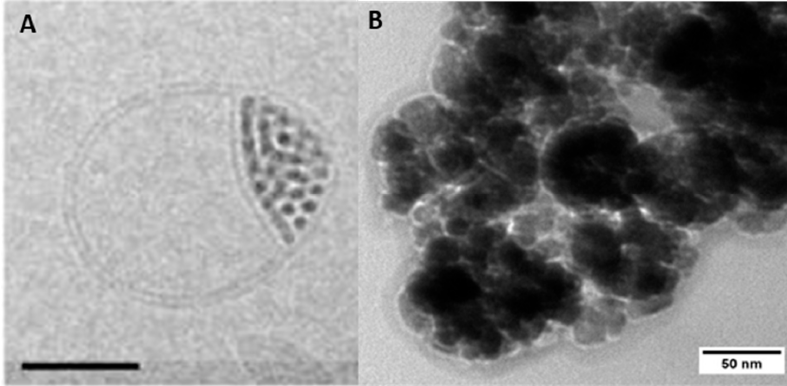
Figure 7. Cryo-TEM (transmission electron microscopy) micrographs of ( A ) lipid bilayer splitting around incorporated MNPs (scale bar = 50 nm). Reprinted from [151] with permission of ACS Publications. ( B ) Protein corona of bovine serum albumin formed at the surface of MNPs (unpublished own data).